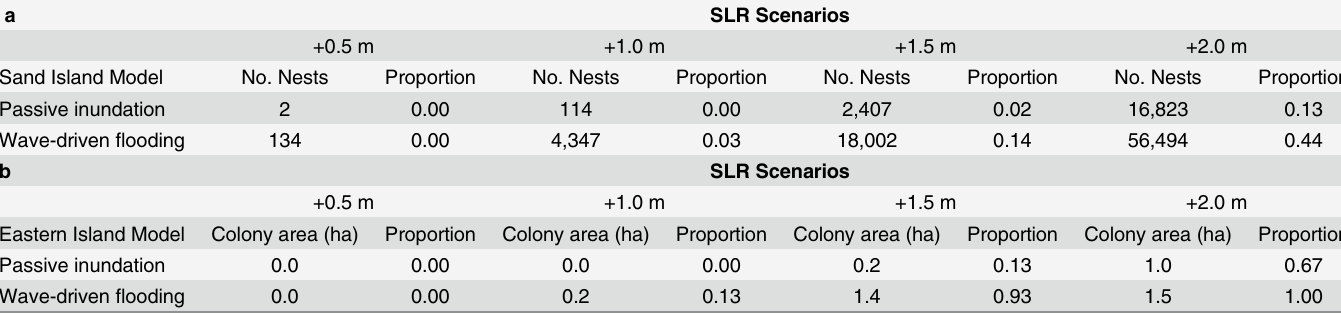
Table 6. Projected Bonin petrel nest inundation on Sand Island (a) and projected colony inundation on Eastern Island (b) for four sea-level rise scenarios and two inundation models, including groundwater rise. Nest distribution and abundance based on the 2008/2009 breeding season survey at Sand (129,534 nests [95% confidence interval: 120,099 – 139,367]) and Eastern (1.5 ha of colony area) islands